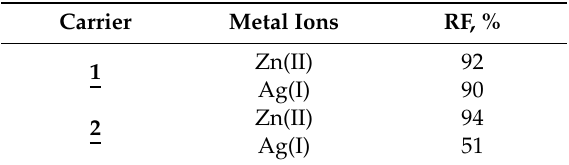
Table 5. The recovery coefficients ( RF ) of Zn(II) and Ag(I) ions from feed phase after 24 h transport